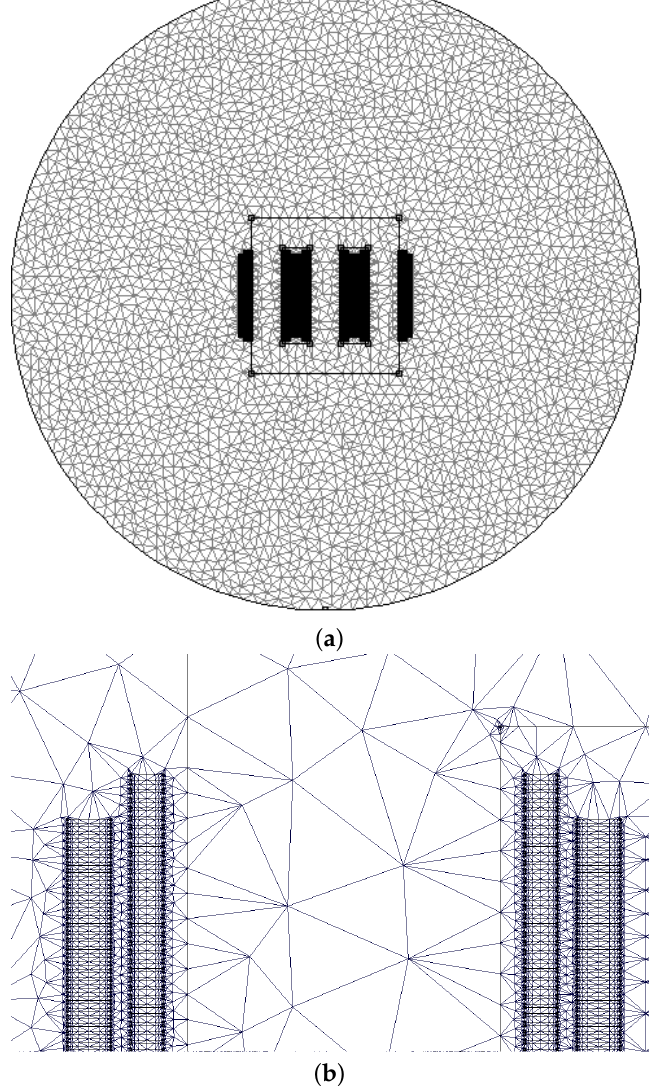
Figure 2. Discretization of 400 MVA power transformer. ( a ) Complete transformer; ( b ) Discretization around the